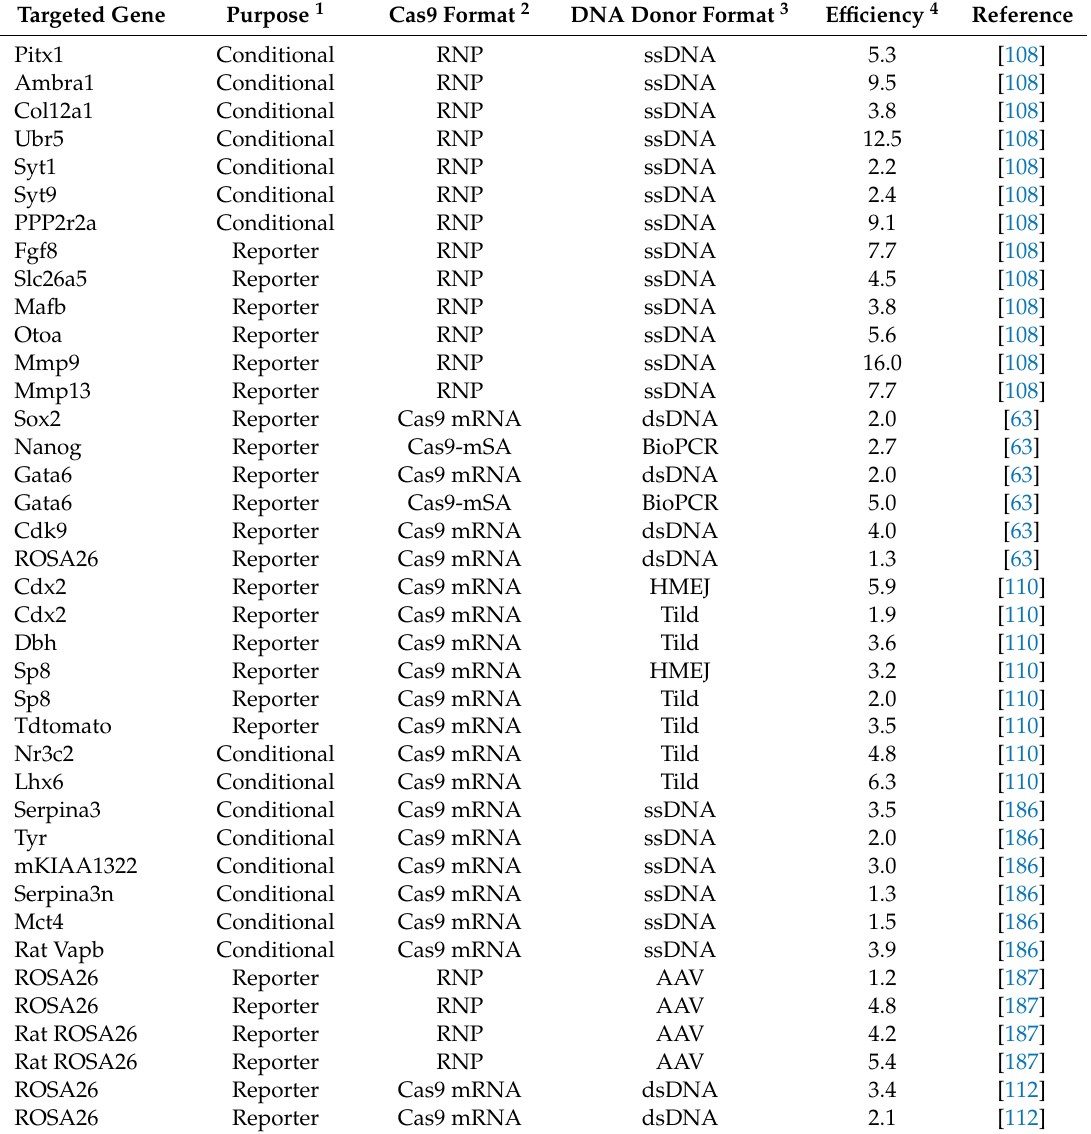
Table 1. Analysis of targeting vector knockin by CRISPR / Cas9 in mouse and rat zygotes. Targeted